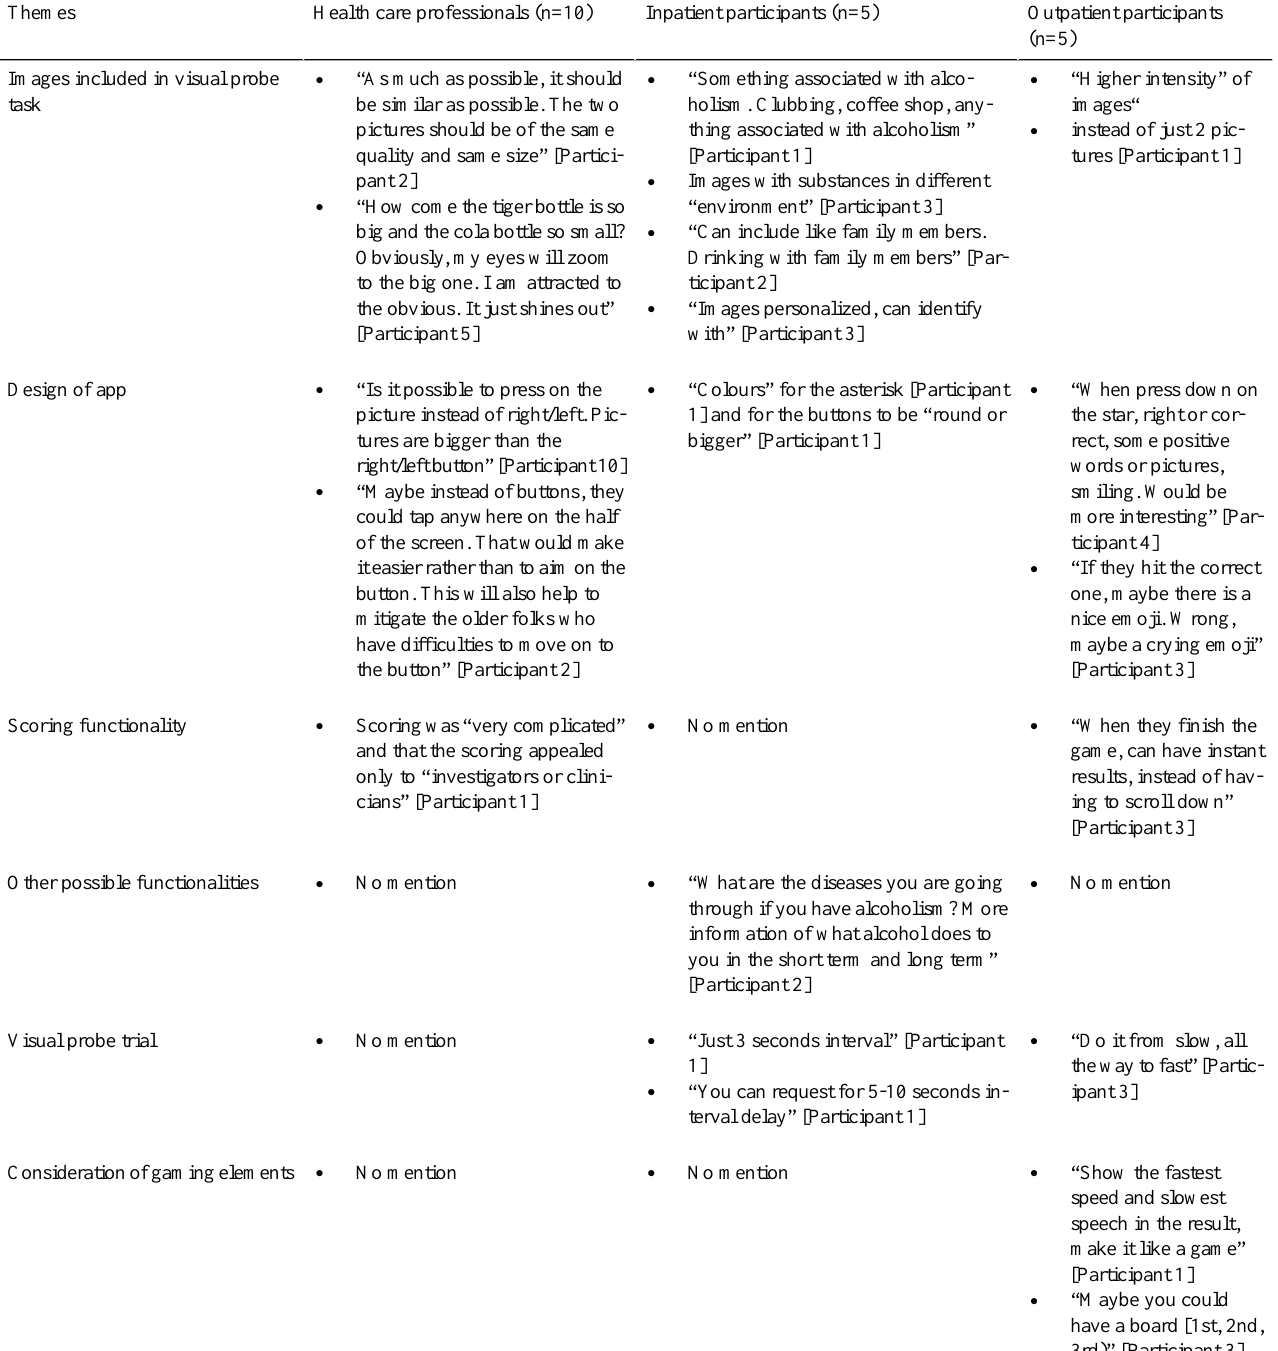
Table 3. Themes related to solutions addressing limitations of the existing